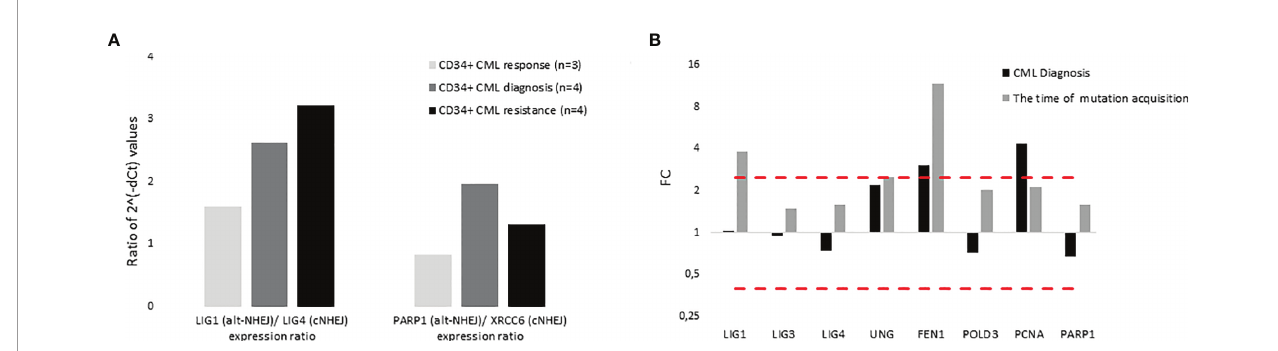
FIGURE 4 | The expression of DNA ligases, their functional partners and BER – long patch genes in primary cells of CML patients. (A) The columns represent the ratios of 2-(Cts-Ctc) values of gene expression for indicated pairs of genes (involved either in altNHEJ or cNHEJ pathway) in CD34+ BM cells of CML patients at the time of optimal response to imatinib (n = 3; Nr. 25, Nr. 27, Nr. 30; light gray), at the CML diagnosis (n = 4; Nr. 25, Nr. 26, Nr. 29, Nr. 31; dark gray) and at the time of resistance to imatinib (n = 4; Nr. 23, Nr. 26, Nr. 28, Nr. 31; black). (B) The black columns represent the fold change (FC; relative expression) of average gene expression in total PB leukocytes of CML patients at the time of diagnosis (n = 3; Nr. 24, Nr. 31 and Nr. 32) compared to gene expression in healthy donors (n = 5; pooled). The gray columns represent the FC of average gene expression in total PB leukocytes of CML patients (n = 2; Nr. 24 and Nr. 32) at the time of fi rst detection of somatic mutations at low levels (RUNX1 D198N 14% + T315I 1% and BCR-ABL1 G250E 1%, respectively) compared to expression in healthy donors (n = 5; pooled). Red dashed lines mark cut-offs indicating strongly differentially expressed genes with FC ≤ 0.4 or ≥ 2.5, similar to inclusion criteria applied for KCL- 22R clones.